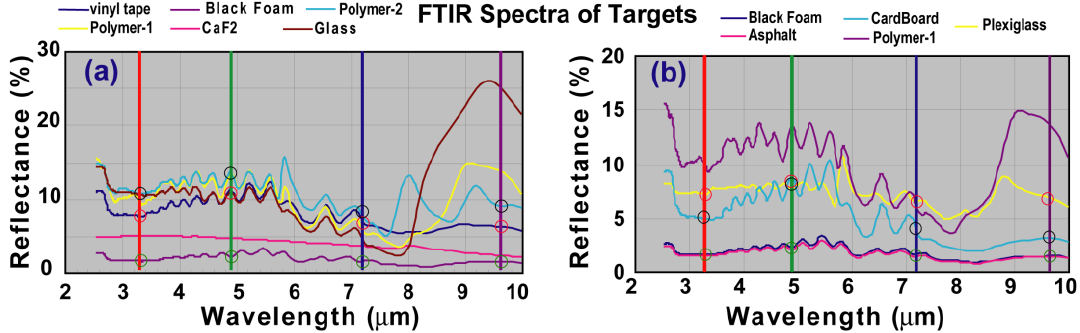
Figure 6. FTIR reflectance spectra of the target materials used in Figure 5. The spectra were calibrated with a gold mirror. The vertical lines mark the laser wavelengths used in spectral imaging. The materials were highly absorptive and systemic background artifact dominates some spectra